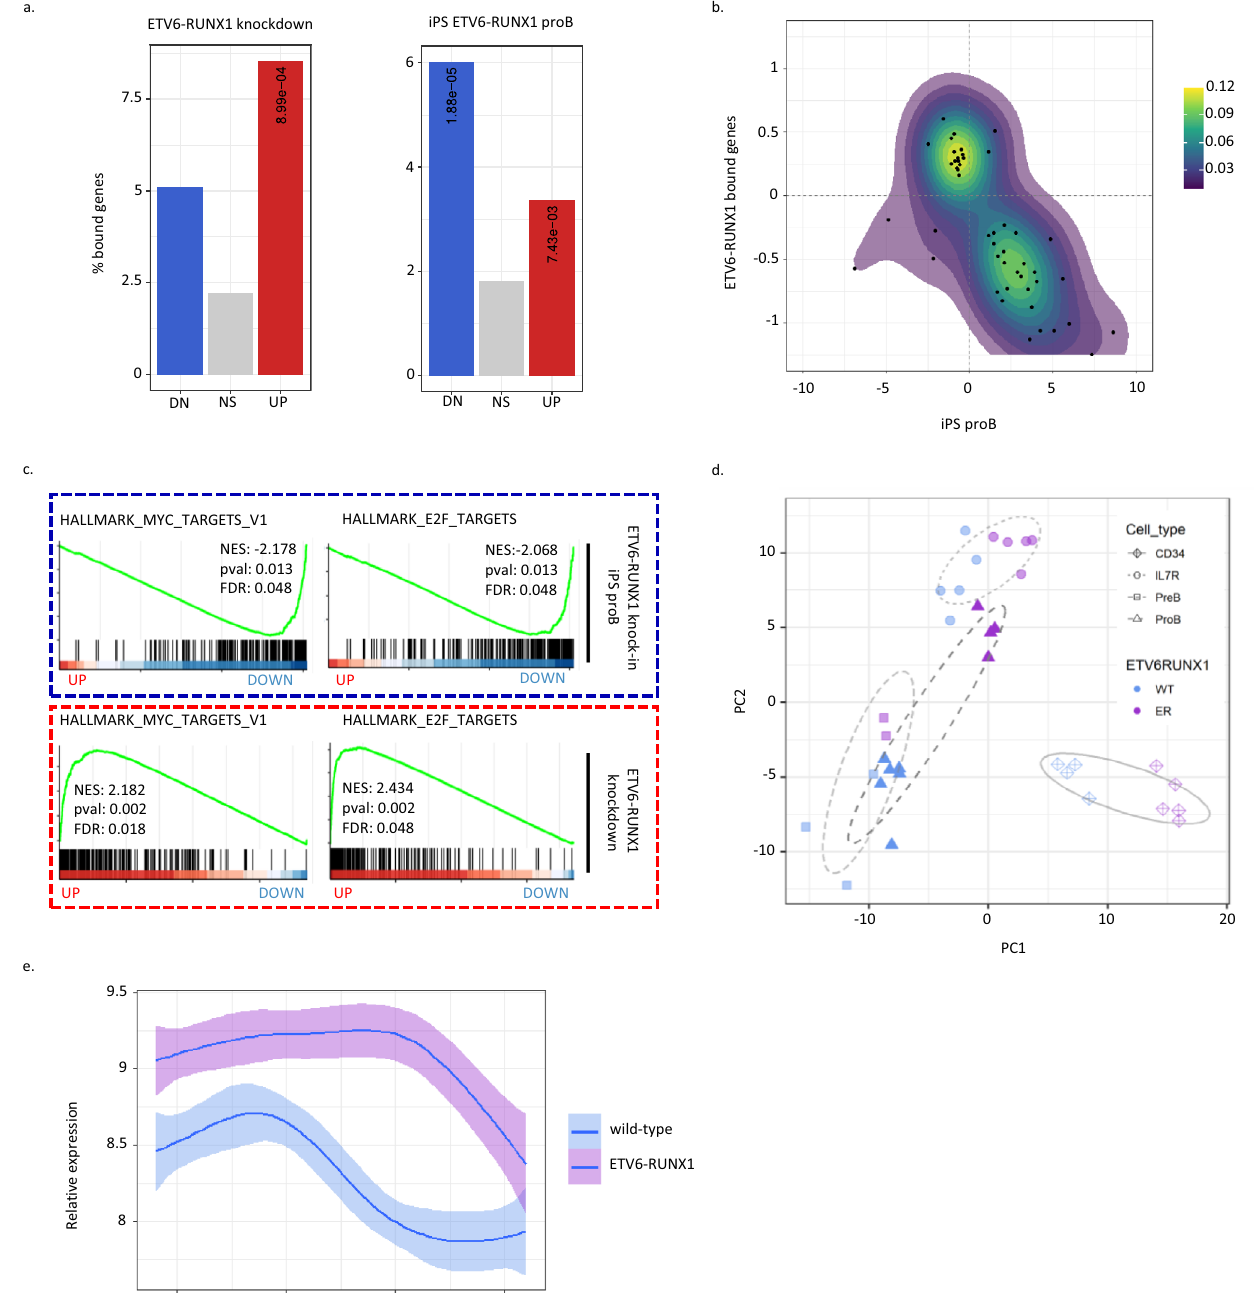
Fig. 2 | ETV6-RUNX1 induces transcriptional changes indicative of cell cycle repression in pre-leukemia. a Bar plot showing percentage of genes associated with an ETV6-RUNX1 binding event for genes signi fi cantly up- or down (dn)-regu- latedornotsigni fi cant(ns, p >0.05)uponETV6-RUNX1knockdowninRehorETV6- RUNX1 expression in proB cells derived from IPSCs. b Dotplot with density con- toursshowinglogfoldchangeforETV6-RUNX1vswild-typeiPSC-derivedproBcells and ETV6-RUNX1 knockdown in Reh. Genes displayed have padj<0.1 in both datasets. c GSEA for ranked gene lists from ETV6-RUNX1 vs wild-type iPSC-derived proB cells and ETV6-RUNX1 knockdown in Reh. d Principal component analysis